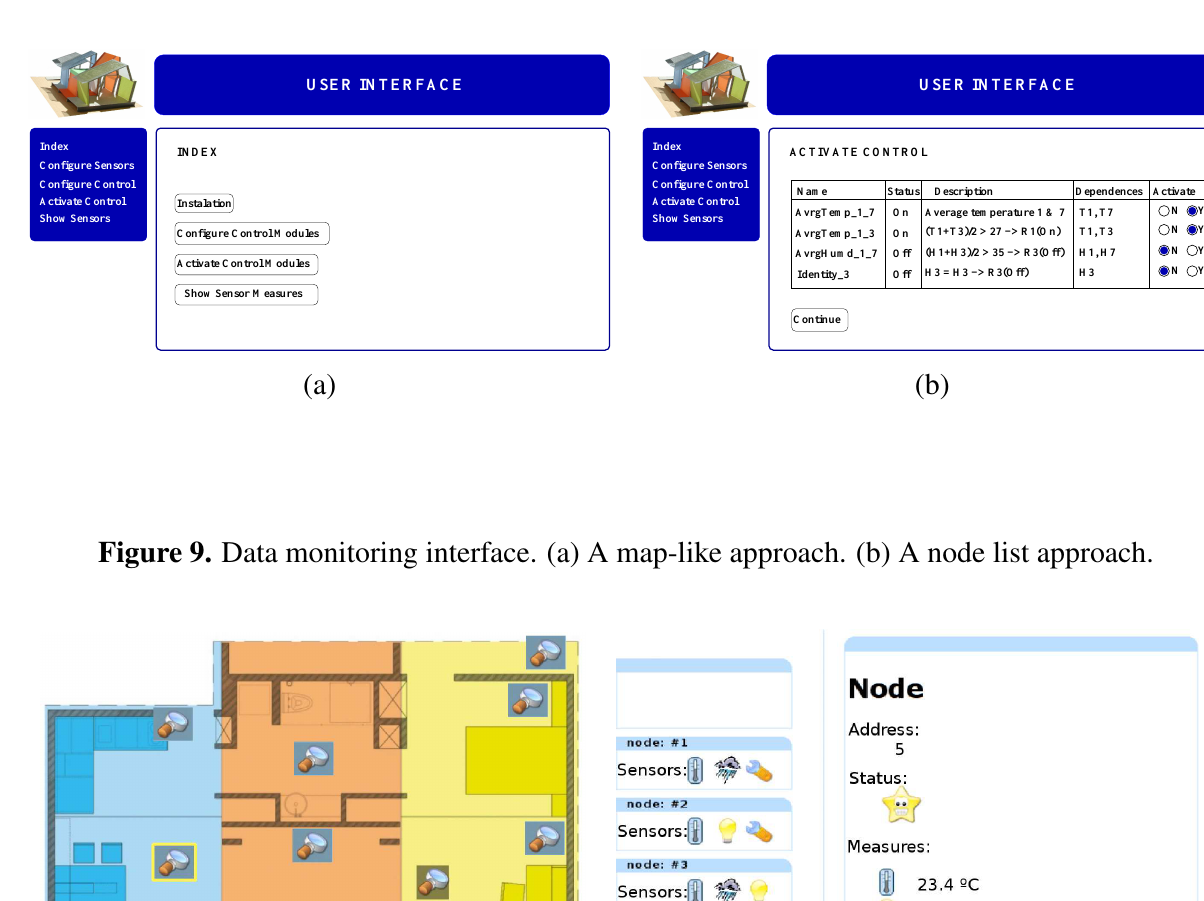
Figure 8. The user interface. (a) Main menu and (b) controller menu.